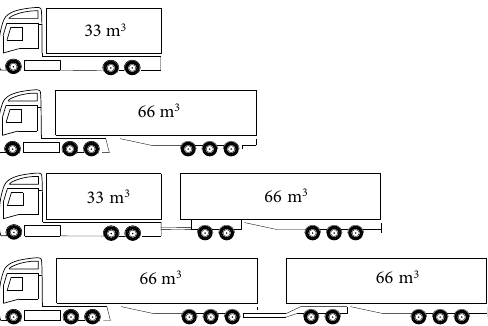
Figure 10. A design set of vehicles with different loading capacities. A small (33-m 3 ) container has a loading capacity of 33 m 3 or 7 tons of the intended freight. Gross combination masses are: 25, 35, 60, 80 tons from the smallest vehicle to the largest one, respectively. Semitrailers may carry two small 33-m 3 containers.